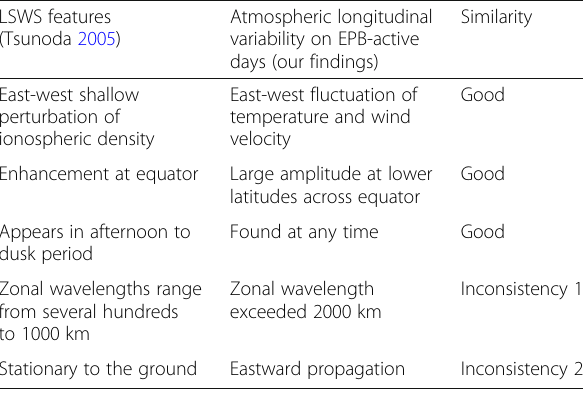
Table 1 Comparison between LSWS features and the results from our study LSWS features (Tsunoda 2005)